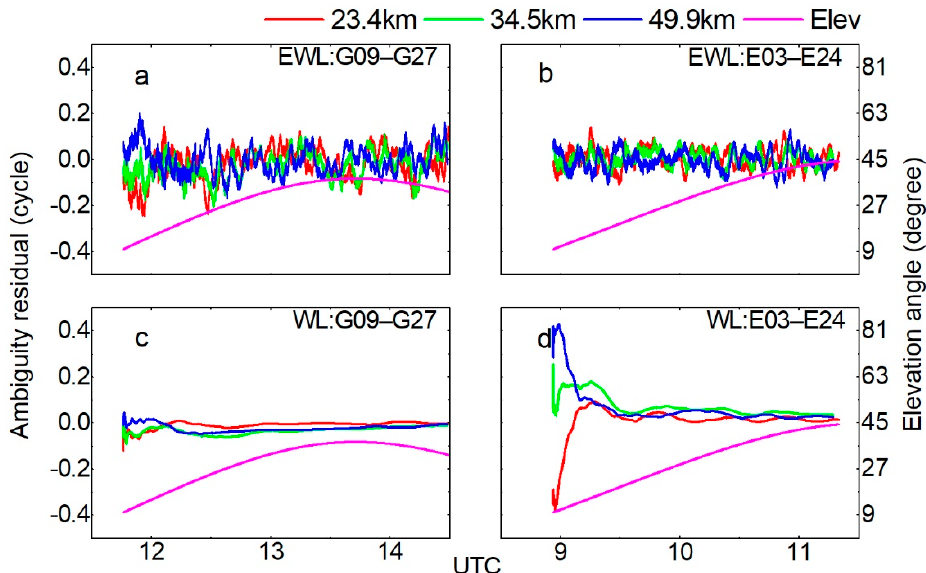
Figure 11. Ambiguity residual of the EWL combination (upper row) and the WL combination (lower row) by CIF TCAR method and corresponding elevation angles ( a , c ) are the EWL and WL of G09–G27; ( b , d ) are the EWL and WL of E03–E24). Table 6. The mean RMS and the convergence time of the CIF TCAR